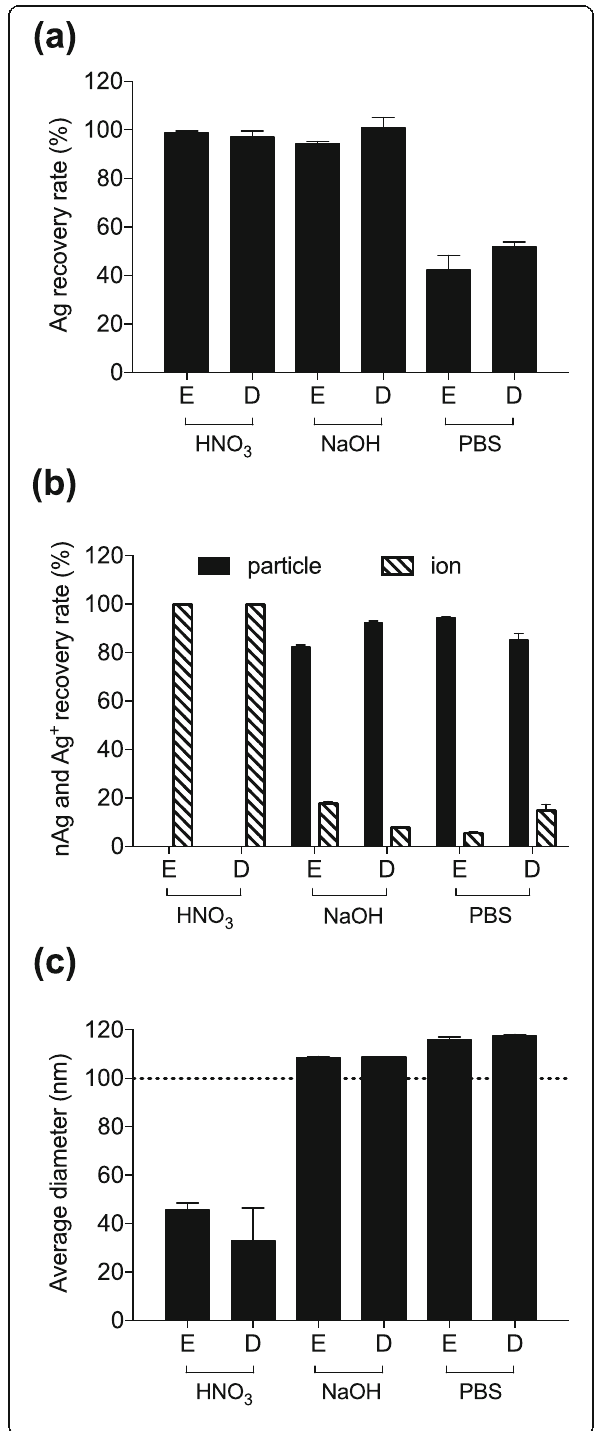
Fig. 2 NaOH pretreatment is the optimal method for detecting nAg100 in dermis and epidermis. Two solubilizing reagents (HNO 3 and NaOH) were screened as pretreatment solvents to lyse tissues. The epidermis (E) and dermis (D) homogenates were mixed with nAg100 to obtain a final Ag concentration of 100 ng/mL and treated with each solubilizing reagent at 37 °C. After 3 h, all samples were analyzed via ICP-MS and sp-ICP-MS. The a recovery rate of Ag, b nAg (black bars) and Ag + (shaded bars) recovery rate, and c average particle diameters are presented. The dashed line represents the initial particle size. The data have been expressed as mean ± S.D. ( n =